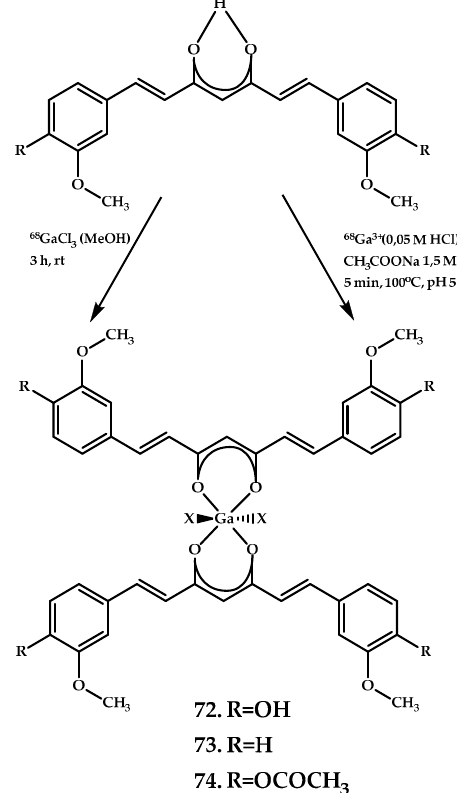
Figure 18. Curcumin-based Ga 3 + coordination compounds 72 – 74 , designed for PET imaging of Figure 18. Curcumin–based Ga 3+ coordination compounds 72–74 , designed for PET imaging of A β plaques.